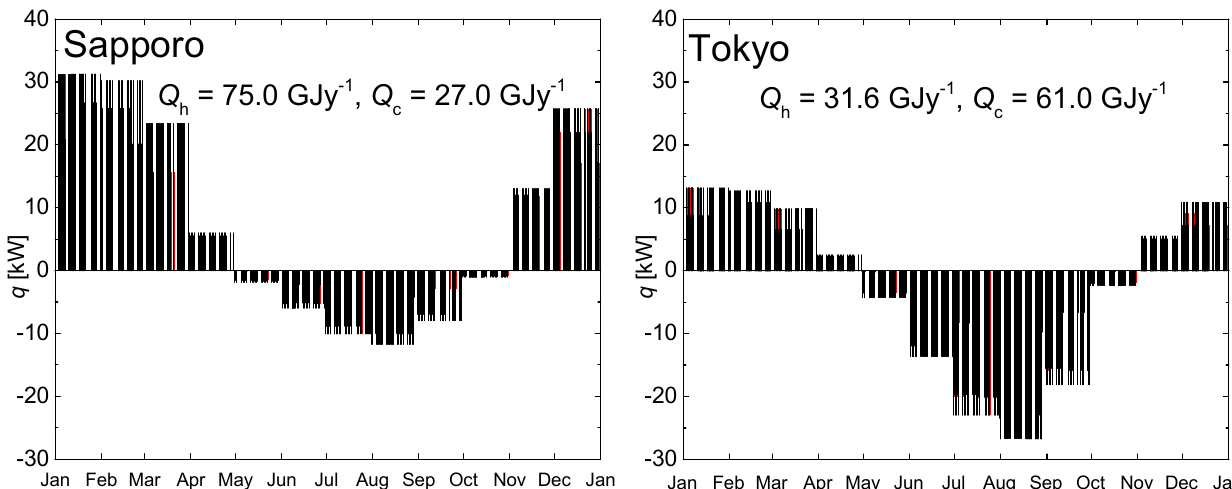
Figure 3. Hourly thermal loads for simulation of cells of Sapporo and Tokyo. Positive and negative values denote heating and cooling, respectively.